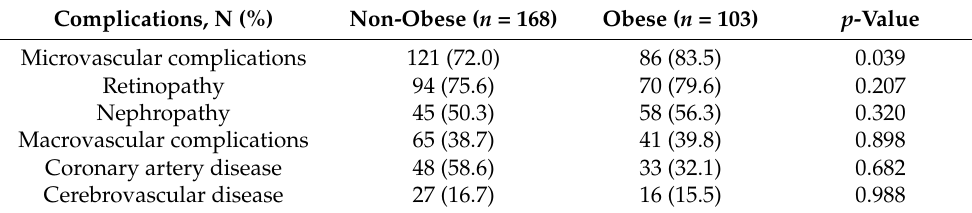
Table 2. Comparison of diabetic complications relative to BMI.